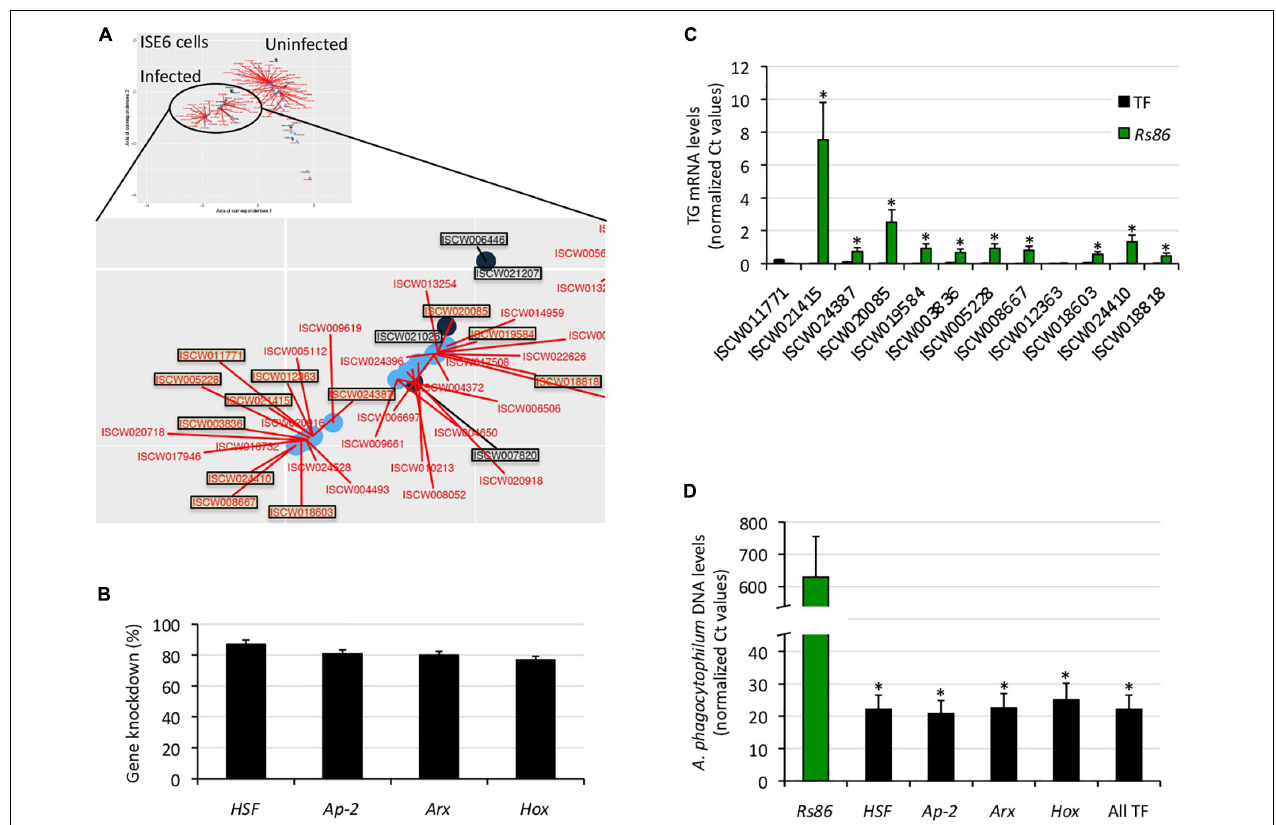
FIGURE 4 | Functional characterization of selected TF-TG components of the tick ISE6 cells regulome. (A) The predictive results of network analysis and in silico prediction of TF-TG interactions were compared in infected ISE6 cells. The TF-TG interactions predicted by both methods (squared in black letter for TF and red letter for TG) were then functionally characterized by RNAi in tick ISE6 cells. (B) Percentage of TF gene knockdown with respect to Rs86 siRNA control in ISE6 cells. Normalized against tick rps4 Ct values were compared between test siRNAs-treated tick cells and controls treated with Rs86 siRNA by Chi 2 -test ( p < 0.05; n = 4 biological replicates). (C) The TG mRNA levels were determined by qRT-PCR in ISE6 cells after TF gene knockdown or treatment with control Rs86 siRNA. Normalized against tick rps4 Ct values (average + S.E.) were compared between test siRNAs-treated tick cells and controls treated with Rs86 siRNA by Chi 2 -test ( ∗ p < 0.001; n = 4 biological replicates). (D) The A. phagocytophilum DNA levels were determined by qPCR in ISE6 cells after TF gene knockdown or treatment with control Rs86 siRNA. Normalized against tick rps4 Ct values (average + S.D.) were compared between test siRNAs-treated tick cells and controls treated with